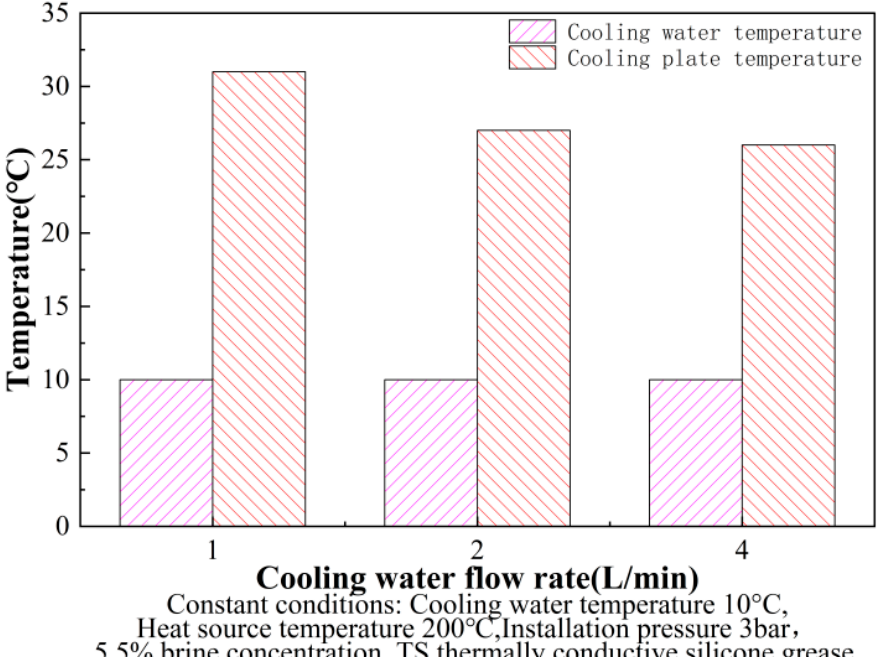
Figure 4. Effect of cooling water flow rate on cooling plate temperature. The effect of cooling water flow rate on the open-circuit voltage and the output power is shown in Figure 5. With the increase in the cooling water flow rate, the open- circuit voltage slightly increases from 21.2 V at 1 L/min to 21.5 V at 2 L/min and remains unchanged at 4 L/min. The growth rate of the open-circuit voltage is 1.42% at 2 L/min and 4 L/min cooling water flow rates as compared to the value at 1